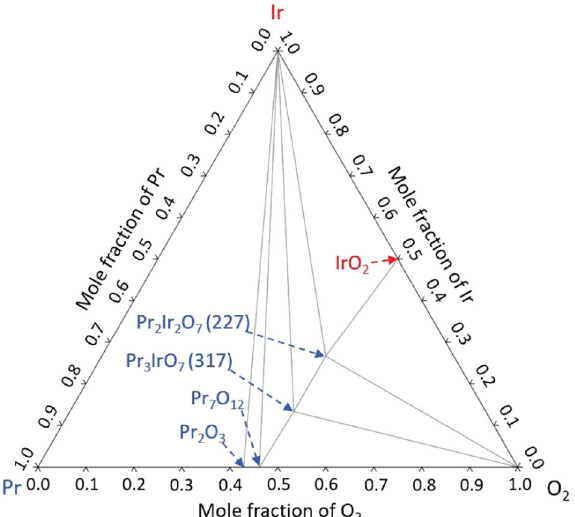
Fig. 3 Calculated isothermal phase diagram of the Pr-Ir-O 2 system with gas phase included. A single point represents the stable condensed phase, the line connecting two points represents the coexistence of the two corresponding phases, and the triangular area connected by three points indicates three-phase invariant equilibria. In the three-phase equilibrium regime around the right bottom corner, the dominant gas species is O 2 (g) with other gas species plotted in Supplementary Fig. 1.